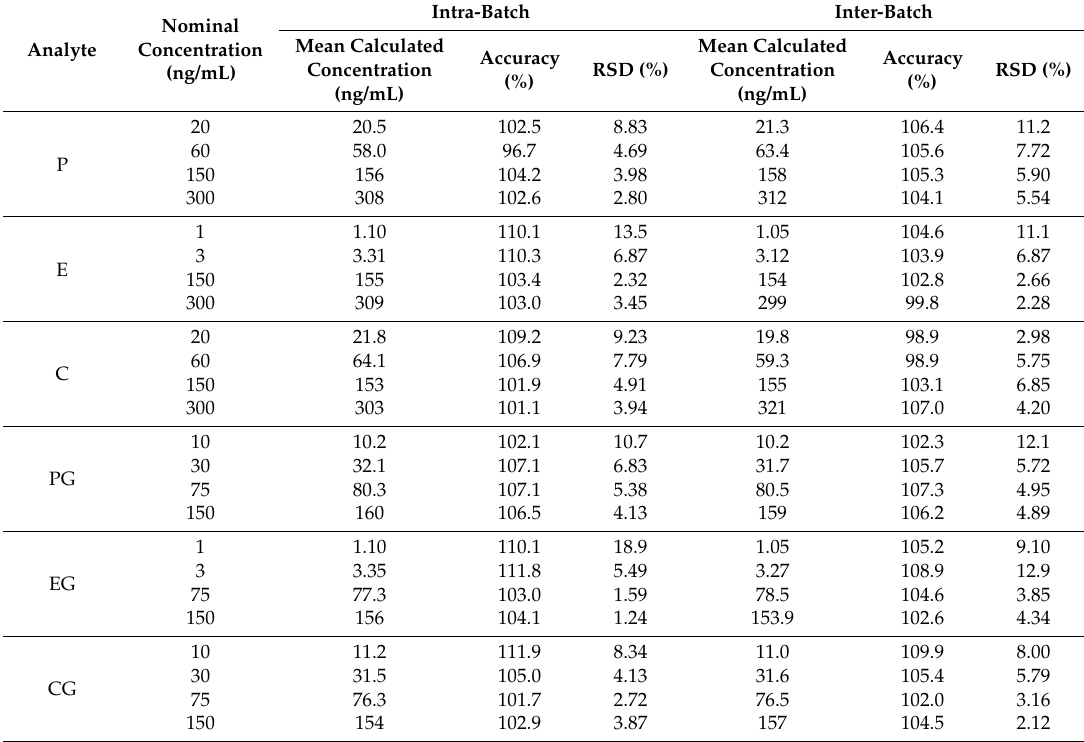
Table 2. Accuracy and precision of anthraquinones in rat plasma ( n = 6). RSD: relative standard deviation.